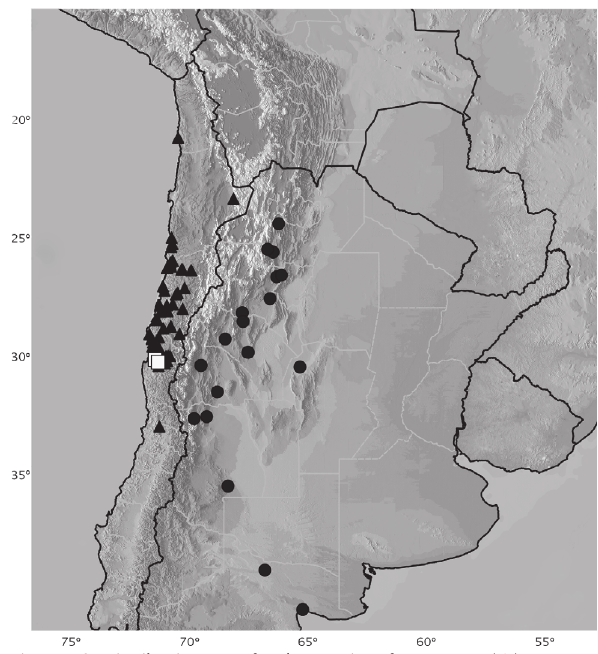
Figure 48. Distribution map for the species of Parasarus : ( (cid:83) ) P. ataca- mensis ; ( (cid:122) ) P. specularis sp. nov. , and ( (cid:133) ) P. spiniventris sp.